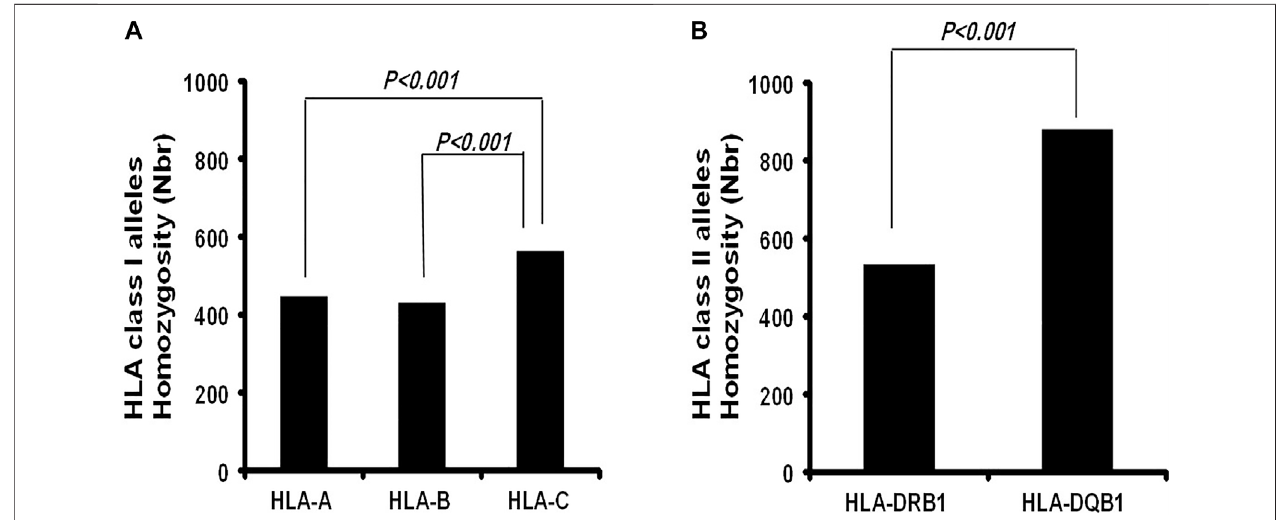
FIGURE 1 | Comparison of the Frequency of homozygosity between HLA class I Loci and HLA class II loci in Saudi population.